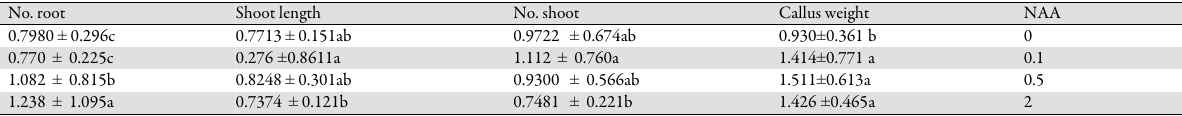
Table 8. The effect of NAA on callus, shoot and root induction of A . annua on MS medium No.